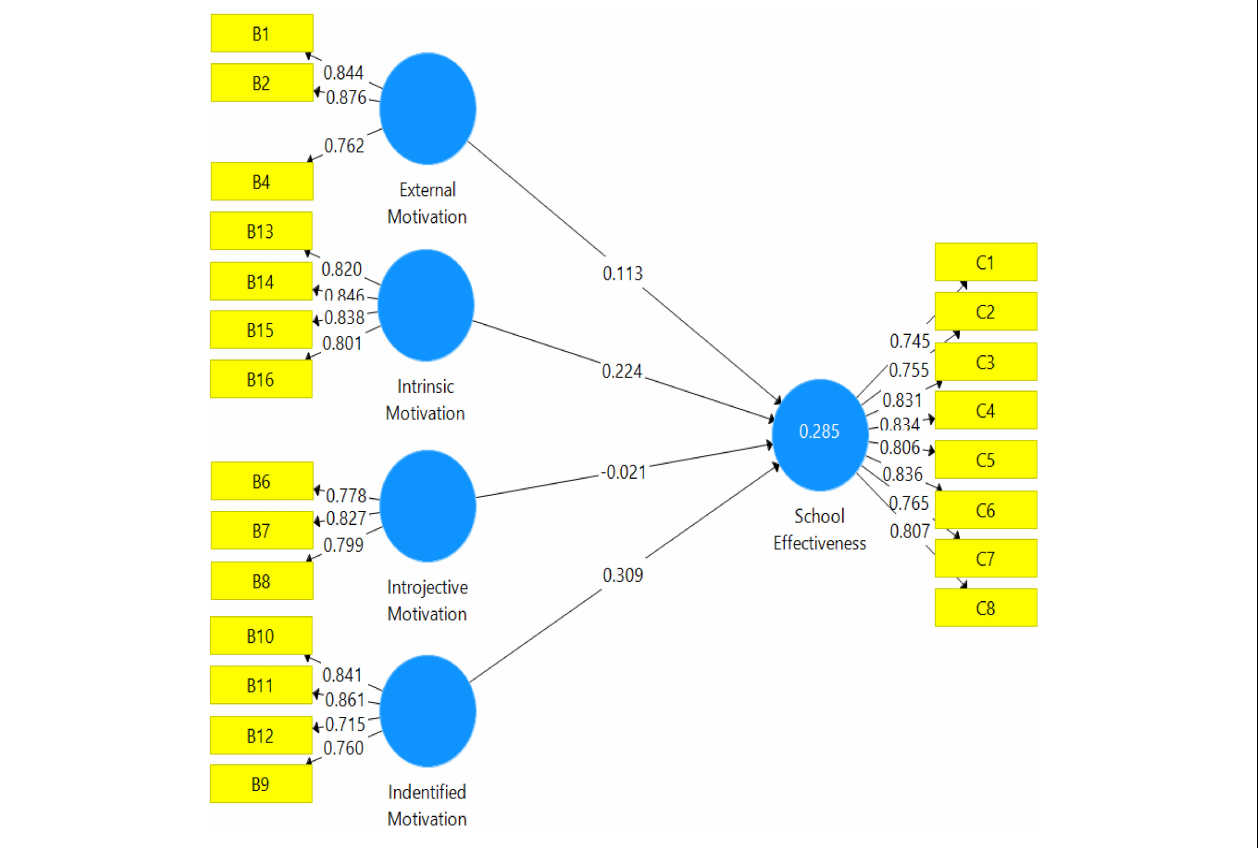
FIGURE 1 | Assessment model analysis